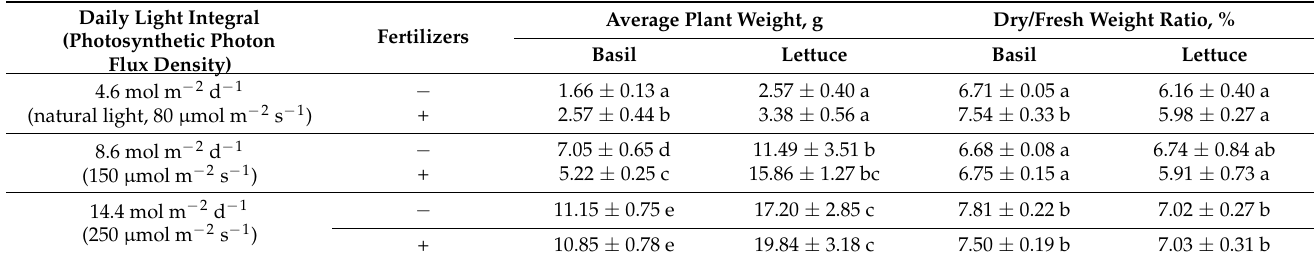
Table 3. Light intensity and fertilization effect on basil and lettuce plant weight and dry and fresh weight ratio. Values are mean ± SE of 5 replicates, and values with different letters in columns differed significantly according to Tukey multiple comparison test ( p ≤ 0.05).